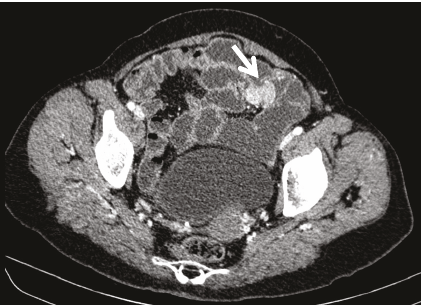
Figure 4: CT enterography — axial CT image with 20-24 mm jejunoileal lesion compatible with GIST.